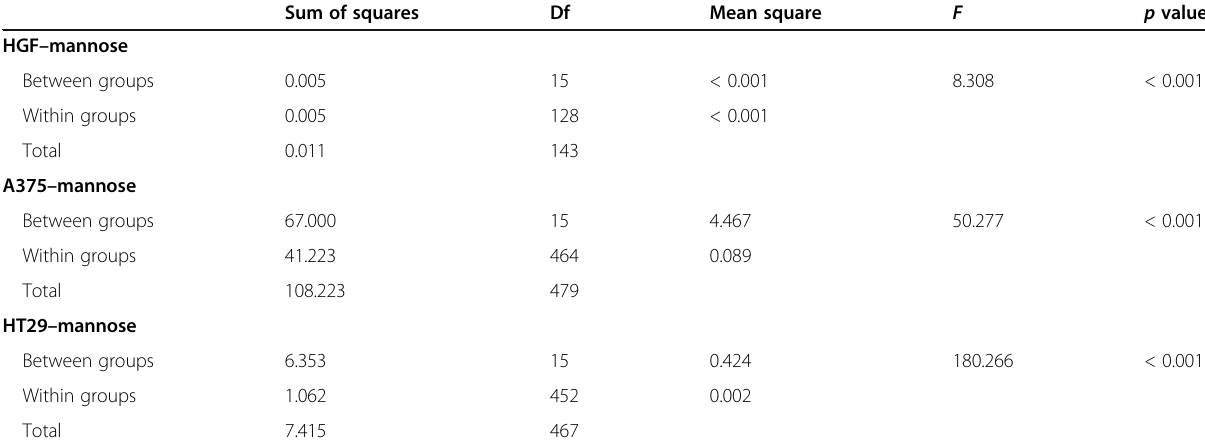
Table 1 One-way ANOVA table Sum of squares Df Mean square